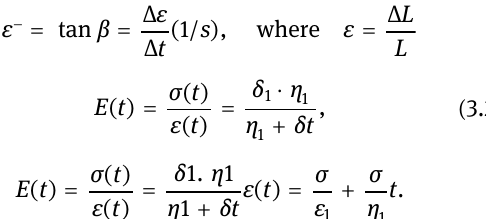
Weight fraction 0% add.